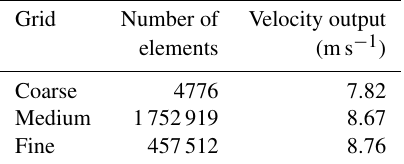
Table 1. Grid convergence study